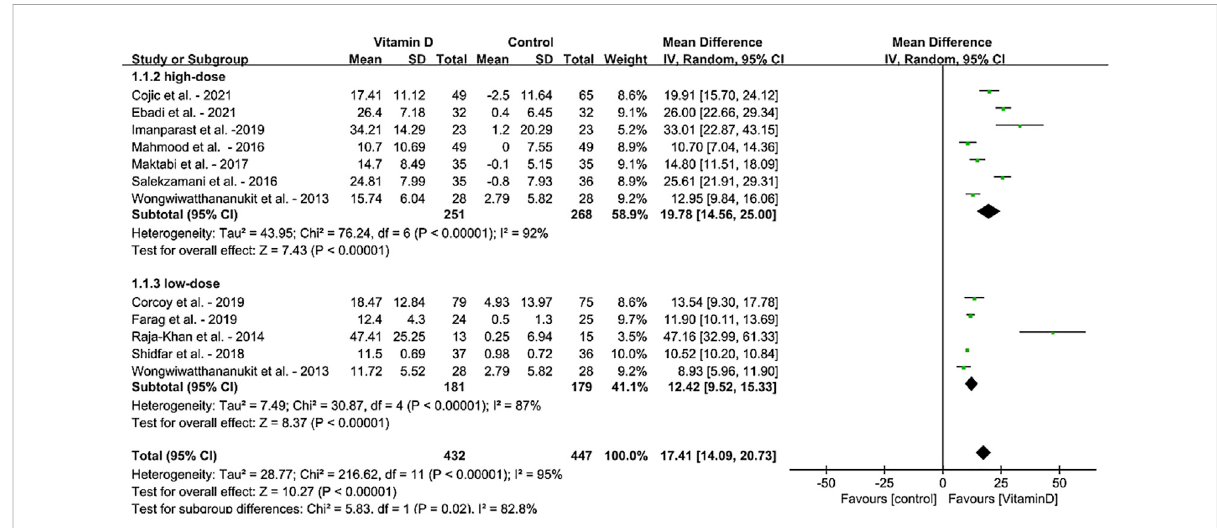
FIGURE 3 ForestplotfortheeffectsofVDSonserum25(OH)D levelsinMetSadults.Thehorizontalbarindicatesthe95%con fi denceinterval(CI).Thesize of the rectangle at the center of the horizontal bar is proportional to the weight of the given study. The diamond at the bottom indicates the pooled mean difference